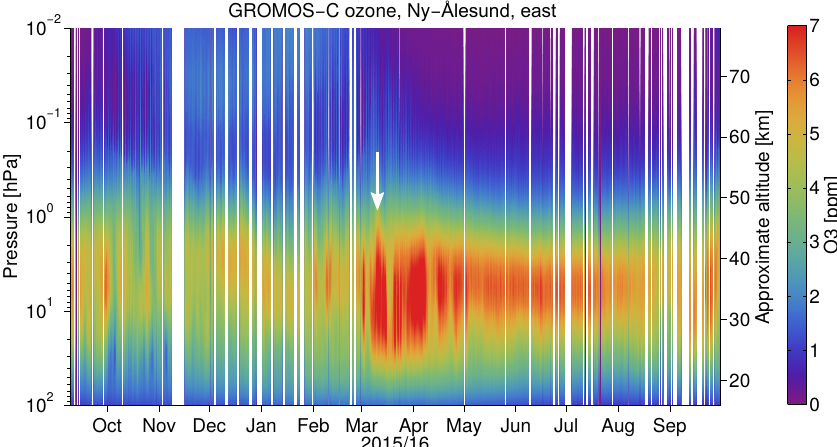
Figure 3. Time series of ozone volume mixing ratio measured by GROMOS-C eastward at Ny-Ålesund. The arrow indicates the sudden stratospheric final warming of March 2016.